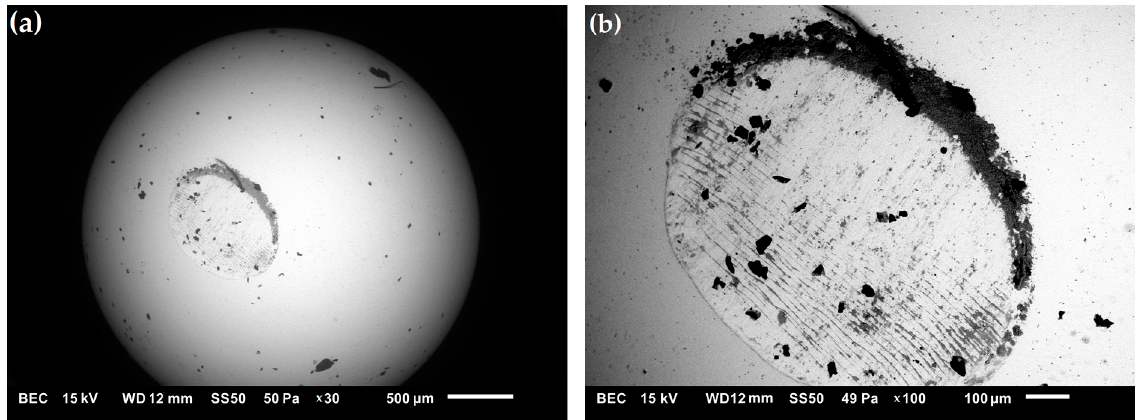
Figure 13. ( a,b ) SEM micrograph of the wear surface of the Al 2 O 3 ball after the tribological test.